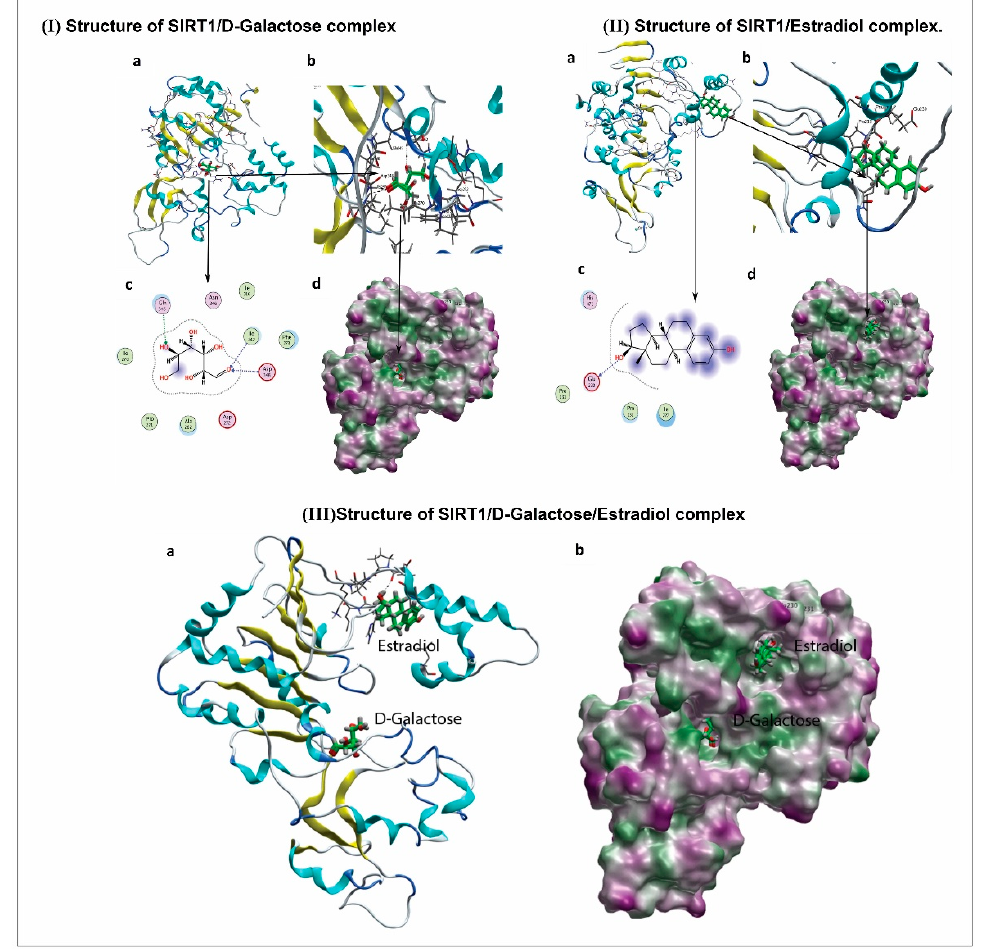
Figure 6. Structure and molecular docking of SIRT1/ D -gal /estradiol complex in ribbon diagram. ( I ) The structure of SIRT1/ D -galactose complex; ( II ) structure of SIRT1/estradiol complex; ( III ) structure of SIRT1/ D -galactose/estradiol complex.